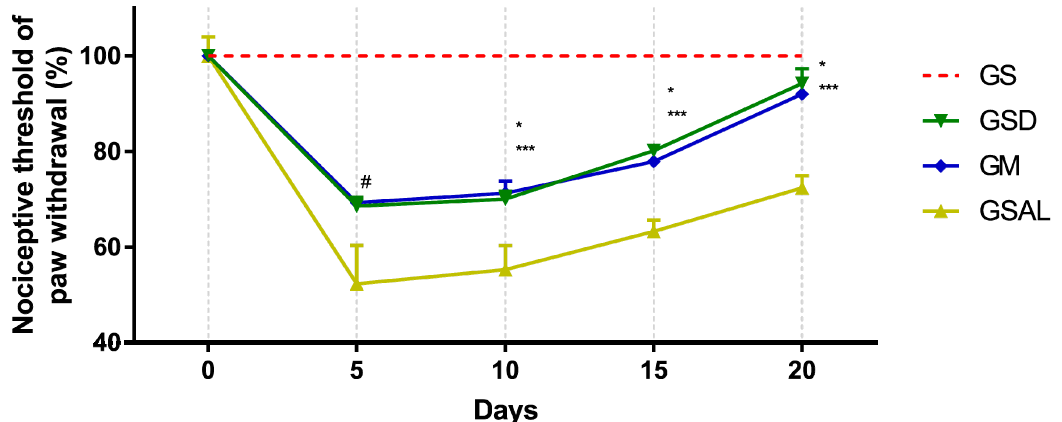
Figure 1. Effect of crude extract of S. dulcis on the tactile sensory evaluation using the Von Frey test. Results were expressed as mean ± standard mean error; # difference between healthy group (GS) and saline group (GSAL) in D5 ( p ˂ 0.0001), GS and Scoparia dulcis Group (GSD) in D5 ( p ˂ 0.0001), GS and meloxicam group (GM) in D5 ( p ˂ 0.0001); * difference between GSD and GSAL in D10 ( p = 0.0015), D15 ( p = 0.0002) and D20 ( p ˂ 0.0001); *** difference between GM and GSAL in D10 ( p = 0.0004), D15 ( p = 0.0016) and D20 ( p ˂ 0.0001), using 2-way ANOVA with the multiple comparisons test ( p <0.05).